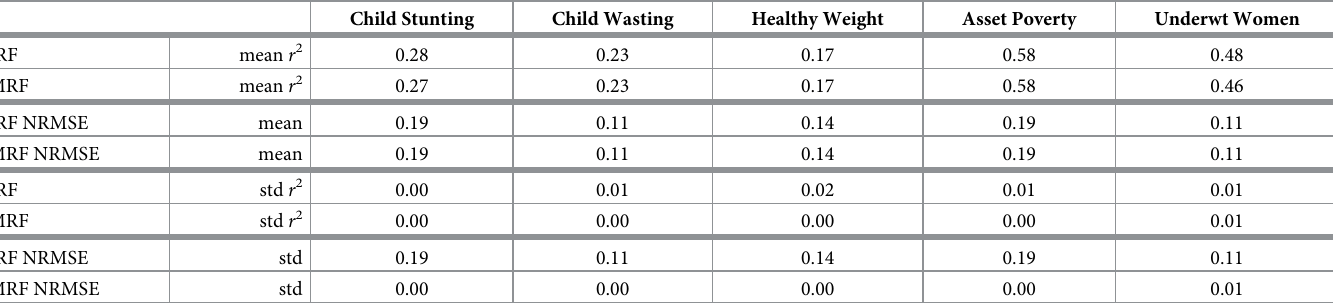
Scores are computed using predictions across all countries and survey years, with mean and standard deviations calculated across 5 folds. Testing and training folds are shared across models.